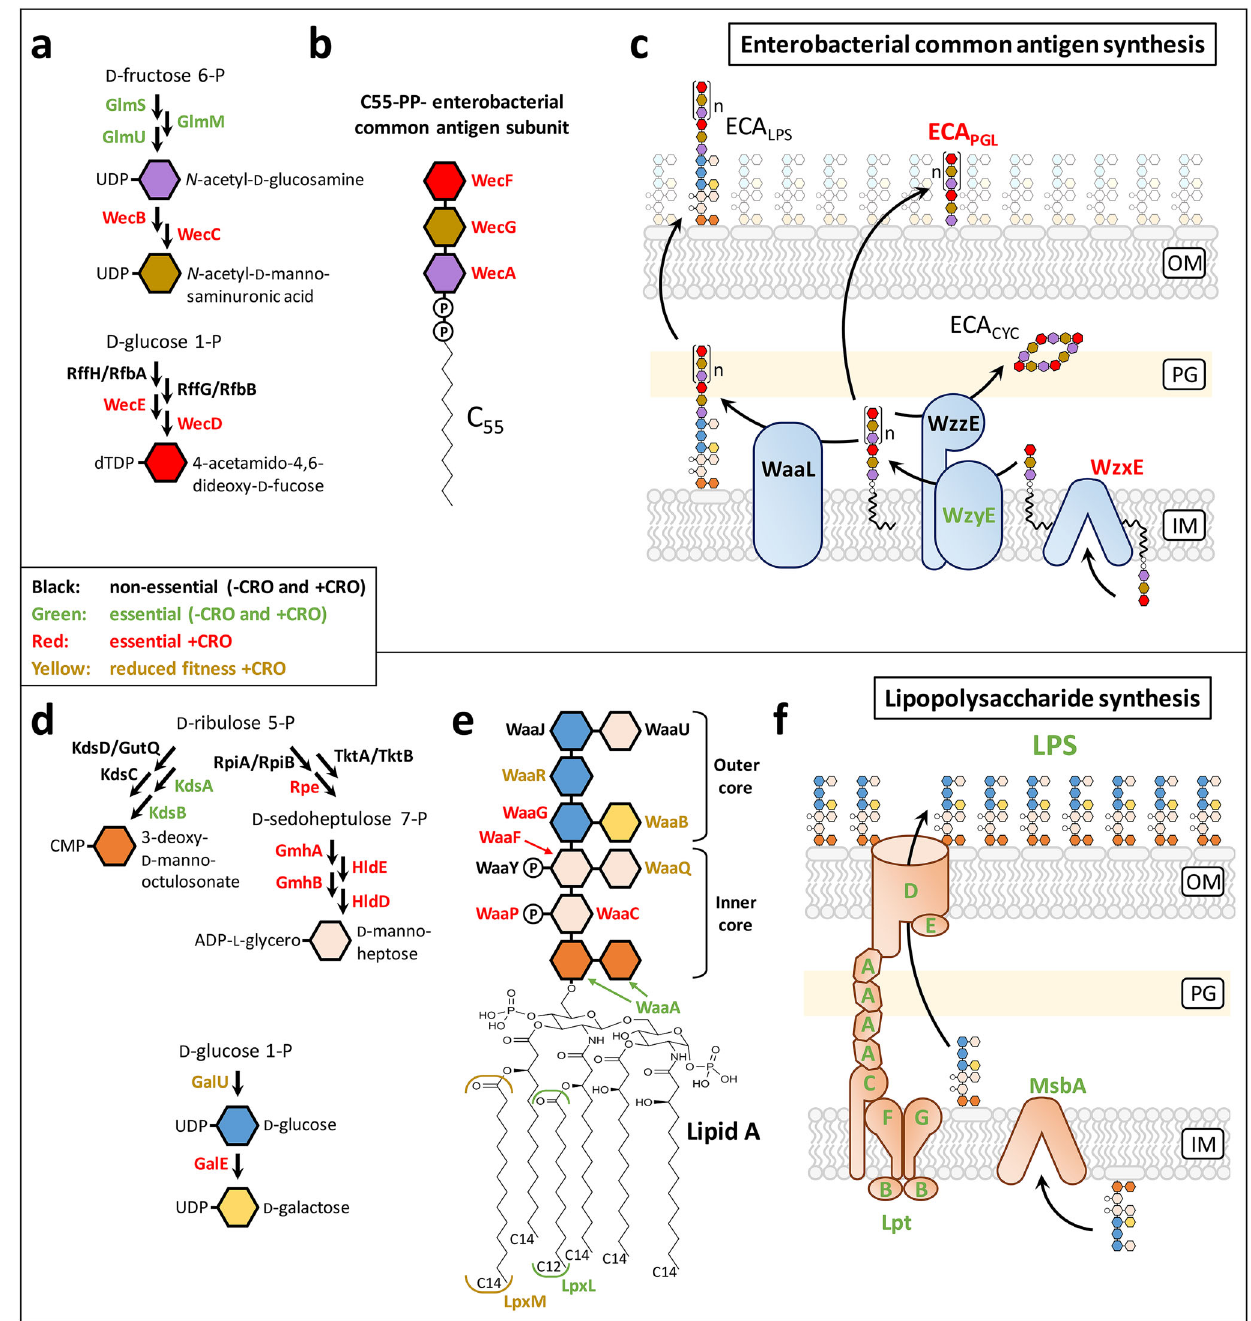
Fig. 5 | Enterobacterial common antigen (ECA) and lipopolysaccharide (LPS) biosynthesis. a Synthesis of ECA nucleotide-sugar precursors. b Assembly of the ECA subunit linked to the undecaprenyl lipid carrier. c Polymerization and trans- port of ECAs to the cell surface. d Synthesis of core LPS nucleotide-sugar